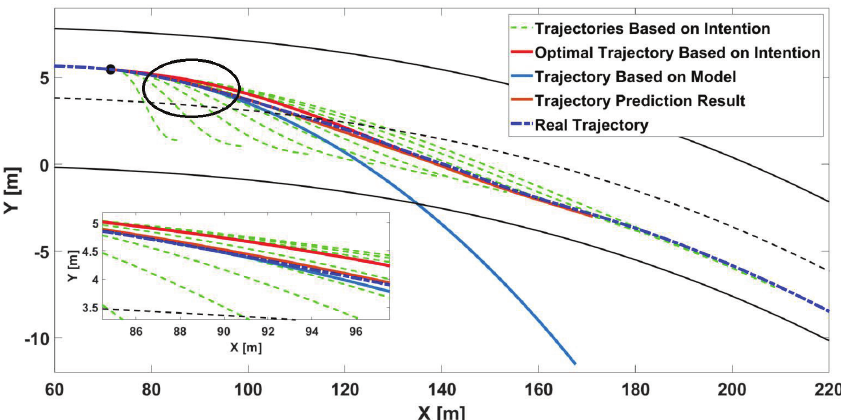
Figure 3. The results of trajectory prediction based on operation intention, vehicle kinematics model, and both operation intention and vehicle kinematics